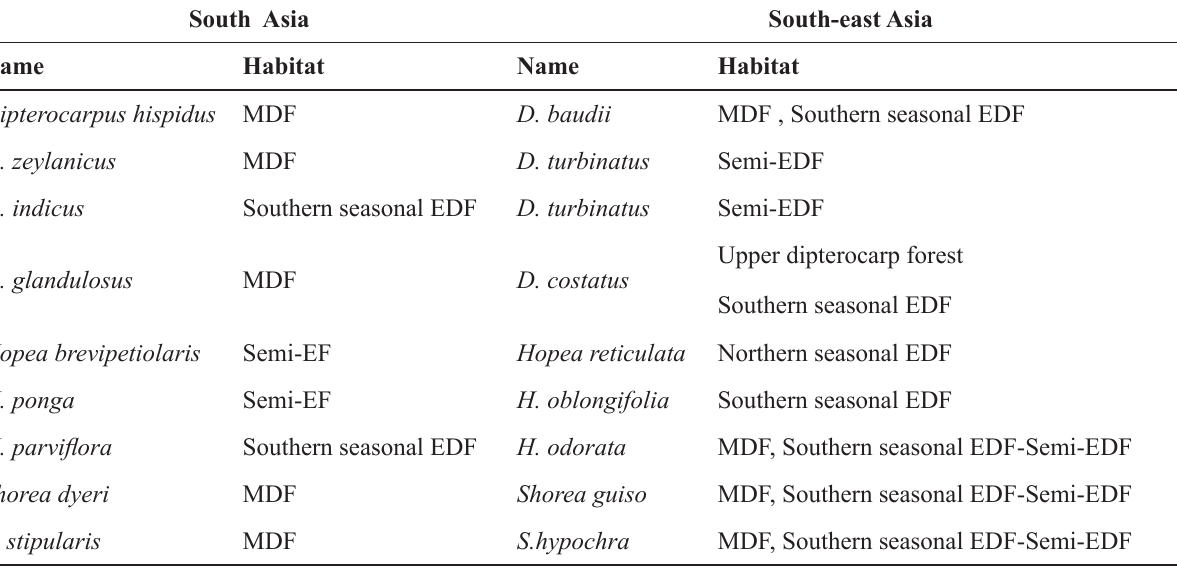
Table 1: Sister dipterocarp species in South and South-east Asia, and their forest formations (from Ashton 2014) MDF: Mixed Dipterocarp Forest, EDF: Evergreen Dipterocarp Forest, EF: Evergreen